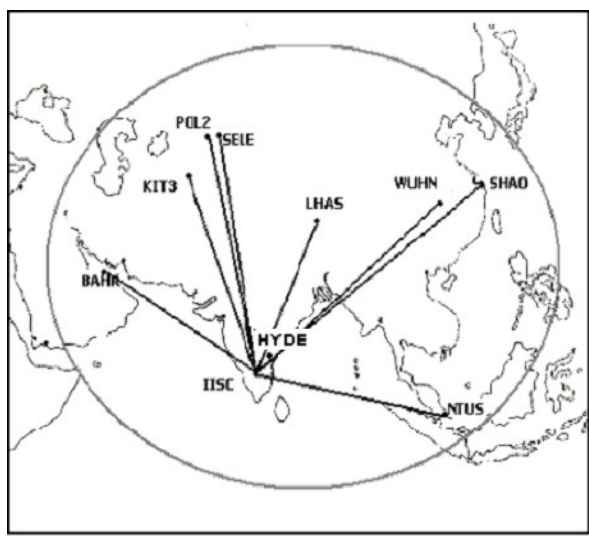
Fig. 1. The network of IGS stations around Bangalore (IISC) and Hyderabad (HYDE) used in the present study. The other stations are Manama (BAHR), Kitab (KIT3), Bishkek (POL2), Almaty (SELE), Lhasa (LHAS), Wuhan city (WUHN), Sheshan (SHAO) and Singa- pore